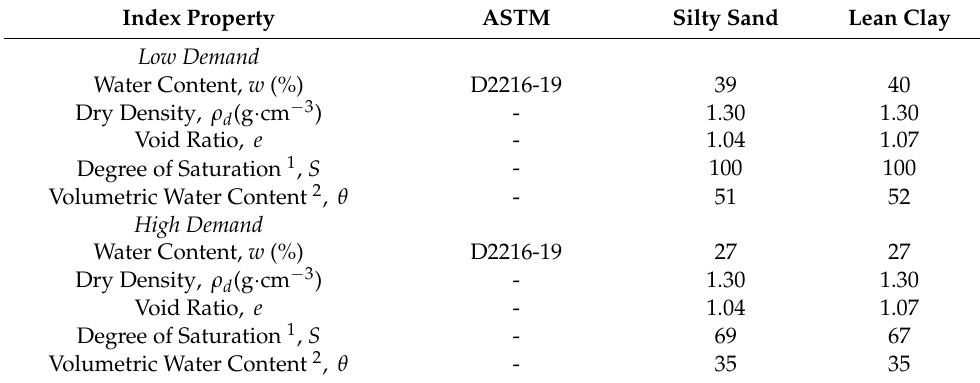
Table 2. Summary of initial conditions of soil samples.